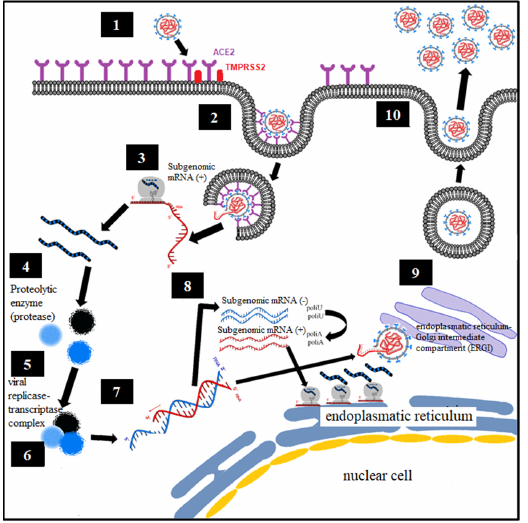
Figure 1. Virological mechanism of SARS-CoV-1 and